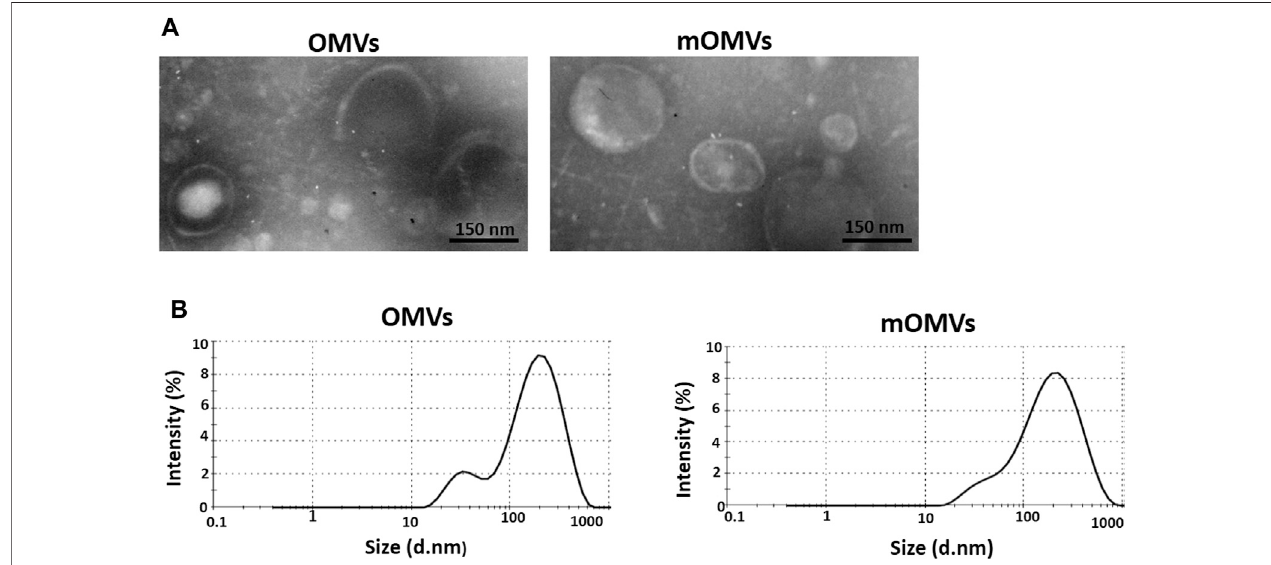
FIGURE2| CharacterizingtheengineeredOMVs. (A) TransmissionelectronmicroscopicobservationoftheOMVs (left) andmodi fi edOMVs(mOMVs) (right). The bar indicates 150 nm. (B) Dynamic light scattering con fi rmed the size distribution of OMVs.